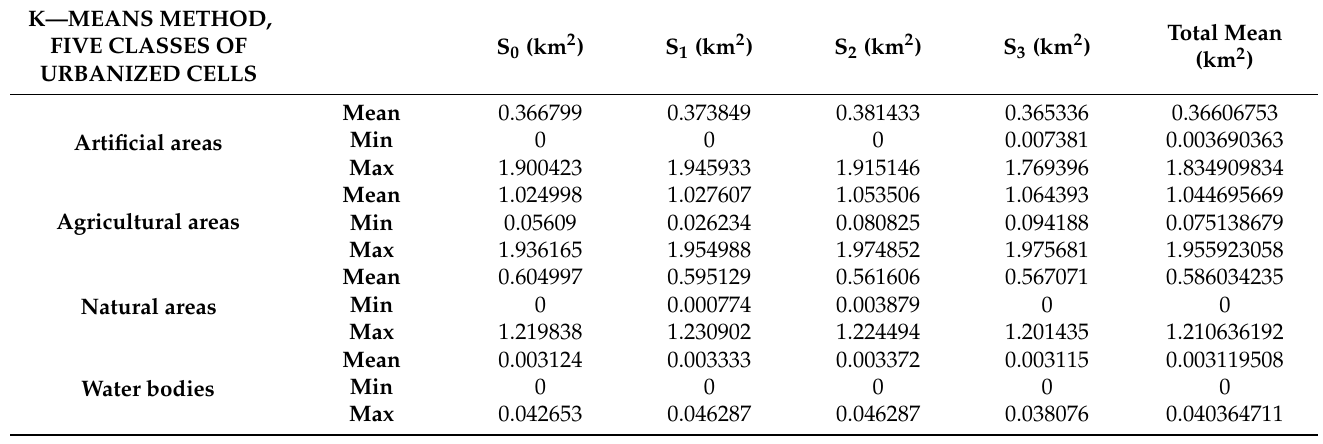
Table 4. Maximum, minimum and mean class values for each grid shift of the best K—Means method (considering only urbanized cells).